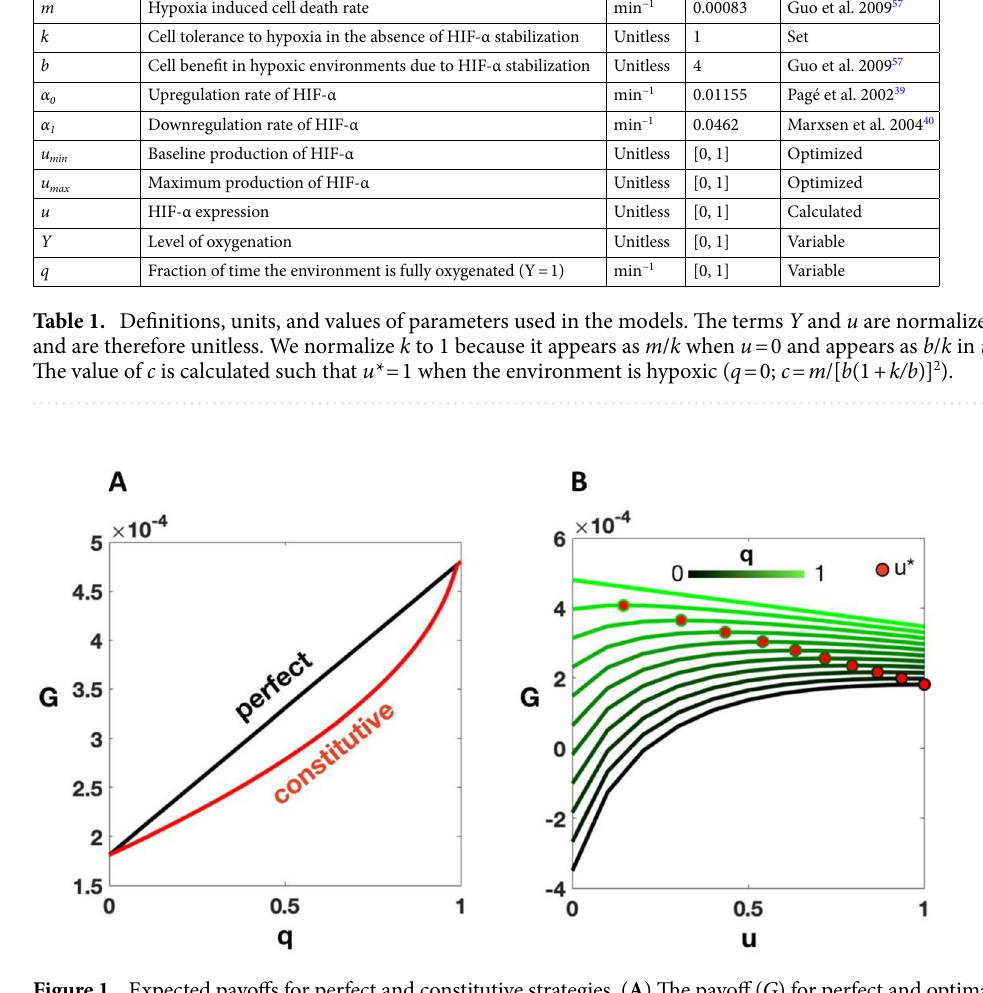
Figure 1. Expected payoffs for perfect and constitutive strategies. ( A ) The payoff ( G ) for perfect and optimal constitutive ( u *) strategies for different fractions of time in normoxic conditions, q . ( B ) The payoff versus HIF-α level, u , for different q ’s. The lines represent all u values, while the red dots represent the optimal u expression ( u *) for each q that maximizes the payoff. Parameter values are given in Table